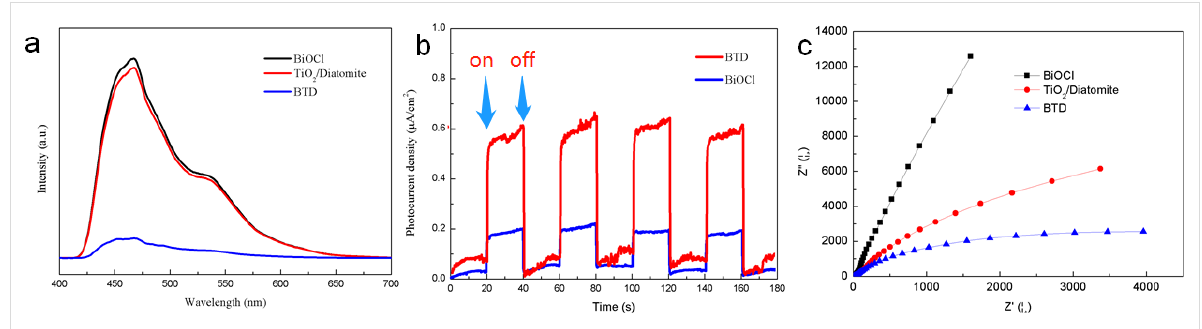
Figure 10: Photoluminescence spectra (a), transient photocurrent spectra (b) and electrochemical impedance spectra (c) of the samples.